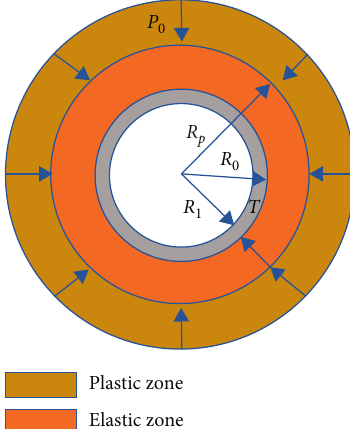
Figure 2: Circular tunnel model in hydrostatic pressure